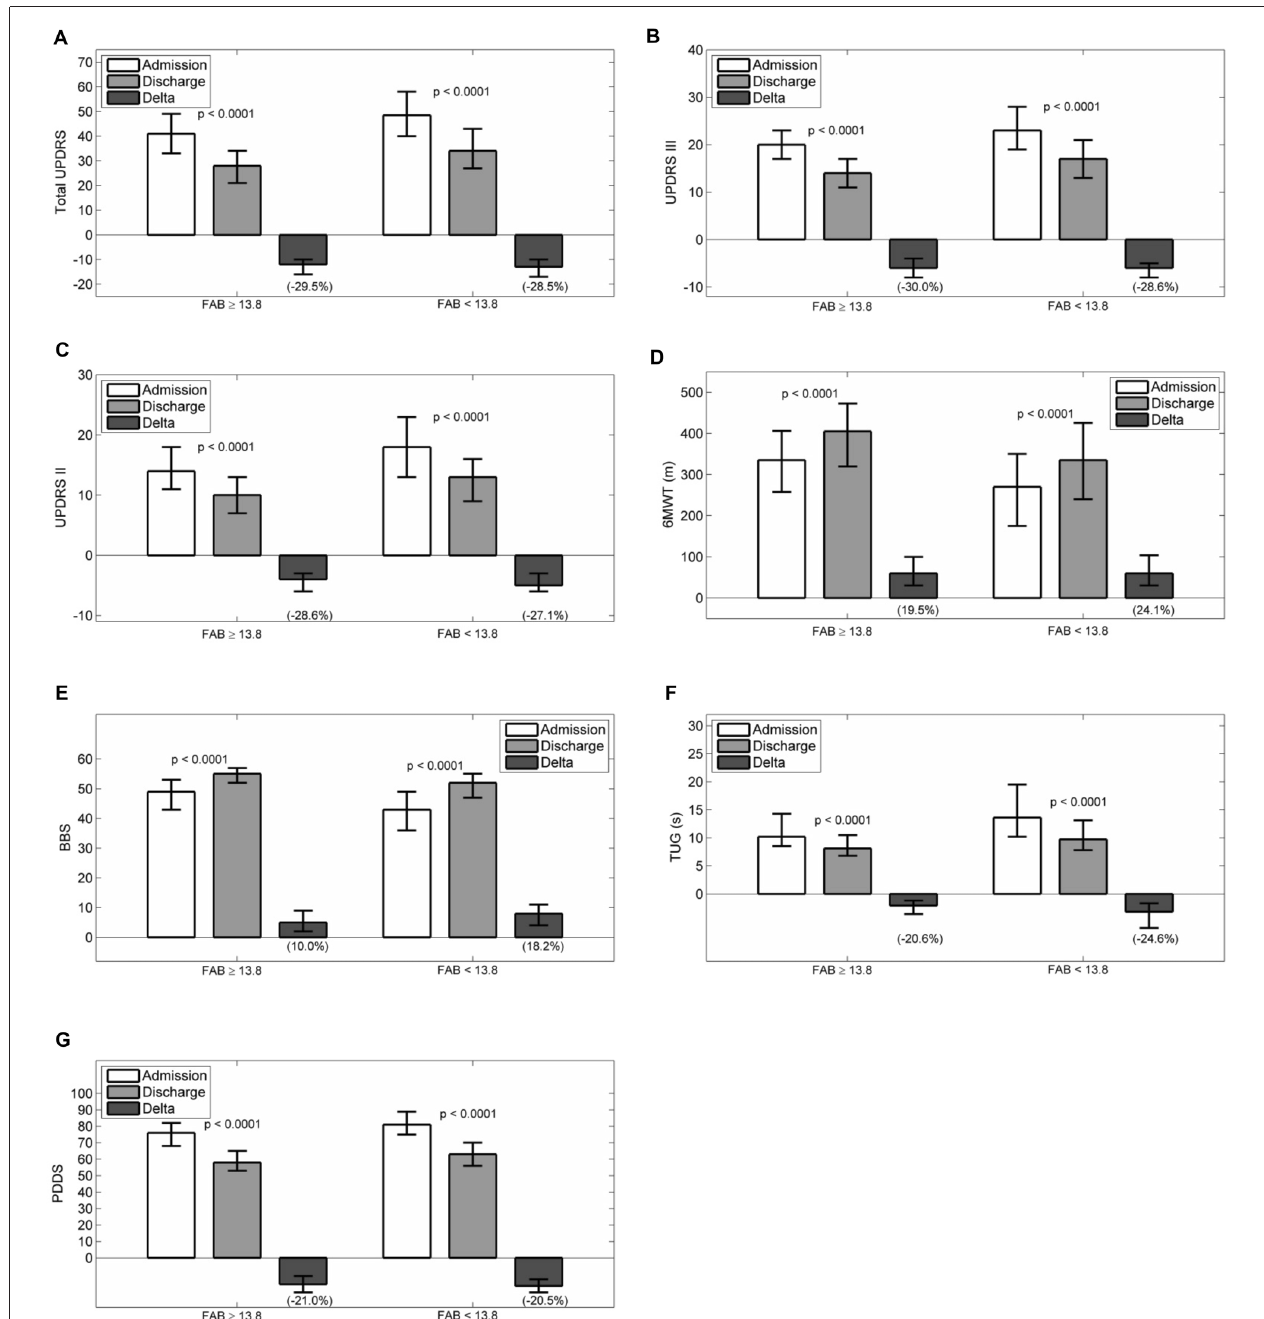
FIGURE 2 | Admission, discharge and delta (discharge-admission) for all the outcome variables in patients grouped according to frontal assessment battery (FAB): (A) Total UPDRS, (B) UPDRS III, (C) UPDRS II, (D) 6MWT, (E) BBS, (F) TUG, (G) PDDS. Data are reported as median (box), lower and upper quartile (whiskers). The percentage value of delta is reported in brackets. The p values are pertaining to the comparison discharge vs. admission. Abbreviations: MMSE, Mini Mental State Examination; UPDRS, Unified Parkinson’s Disease Rating Scale; 6MWT, Six Minutes Walking Test; BBS, Berg Balance Scale; TUG, Timed Up and Go Test; PDDS, Parkinson’s Disease Disability Scale